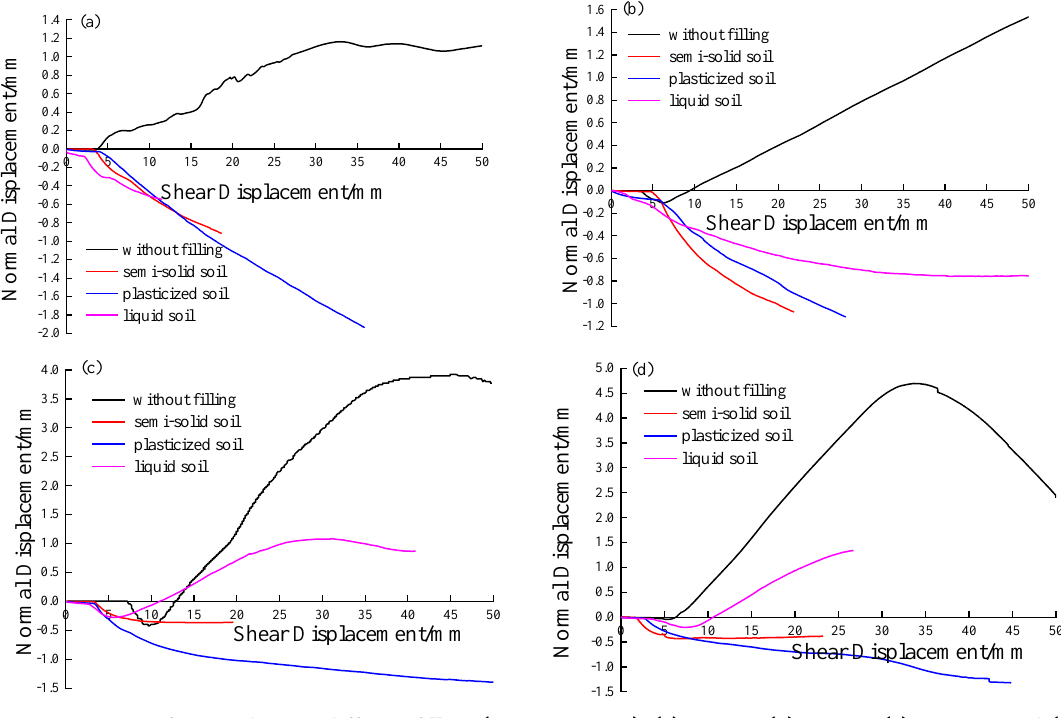
Fig.11. Test curve of ND and SD in different filling (NS is 0.5 MPa): (a) JRC=3; (b) JRC=7; (c) JRC=15; and (d) JRC=19.